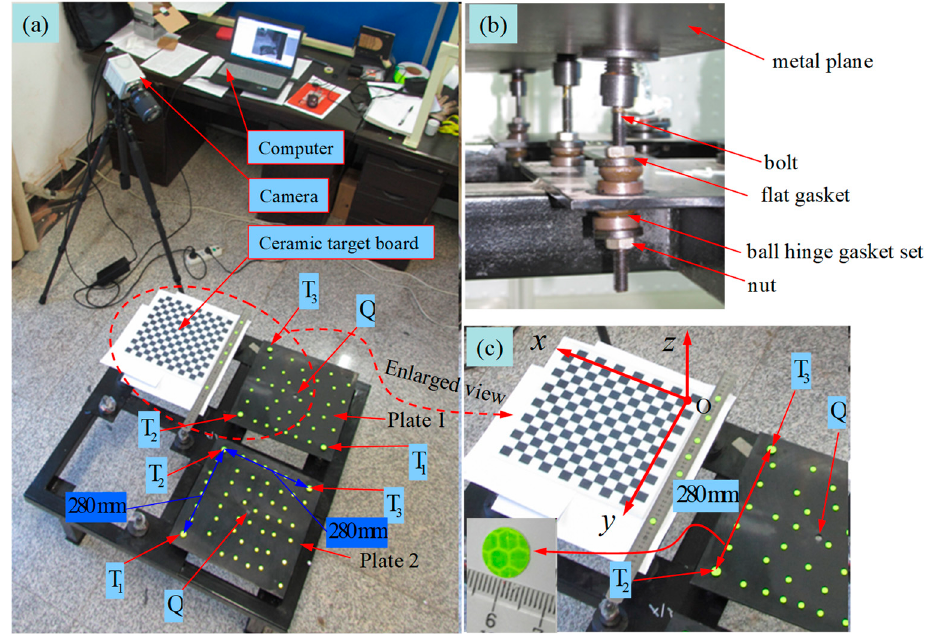
Figure 9. Experimental device for the facet alignment of a metal plane. ( a ) Experimental system, ( b ) support bolt structure and ( c ) circular markers. Table 2. Coordinates of the ball ‐ hinge centers, feature points and facet parameters of Plate 1 and 2.